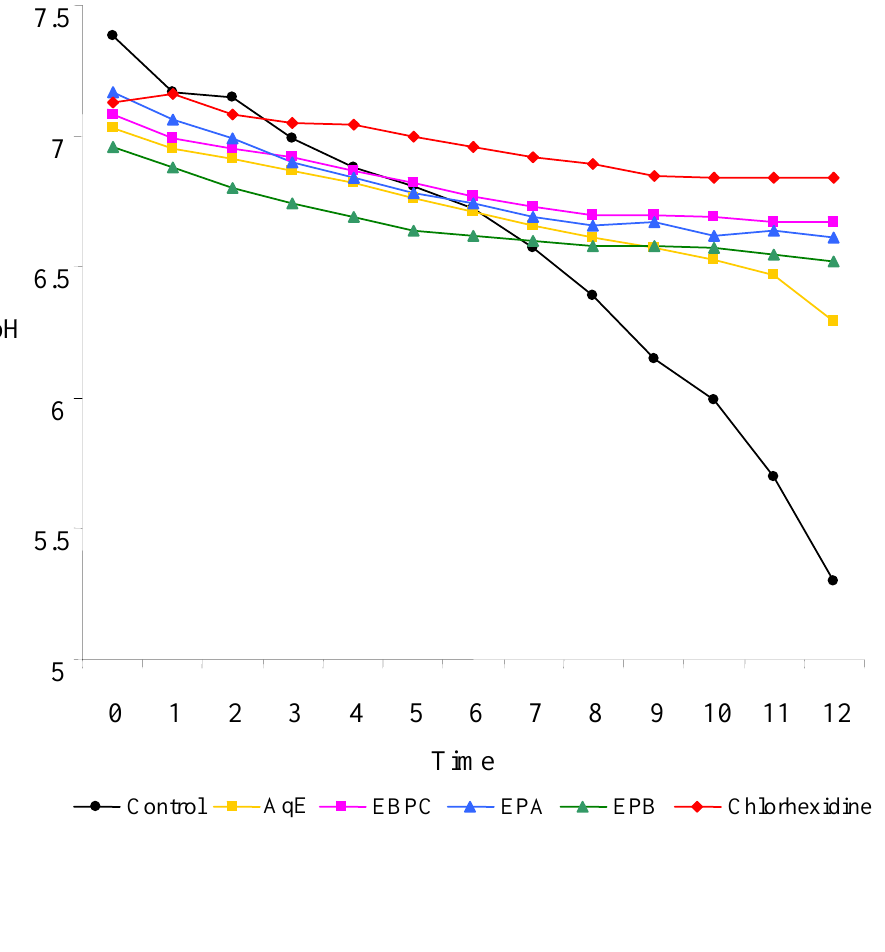
Figure 4 – Effect of the samples in reducing production of acids by Streptococcus mutans